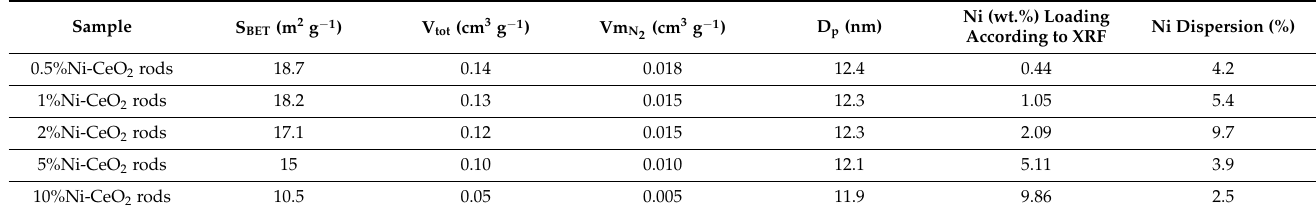
Table 4. Textural characteristics of Ni-CeO 2 rods samples and XRF analysis.